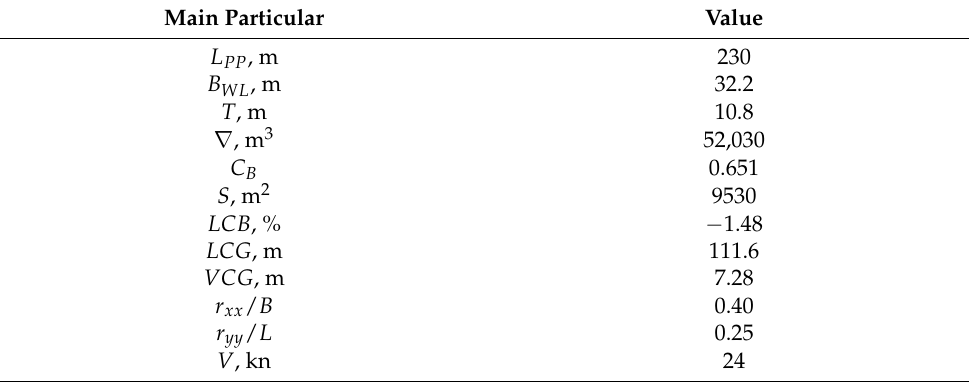
Table 1. The main particulars of